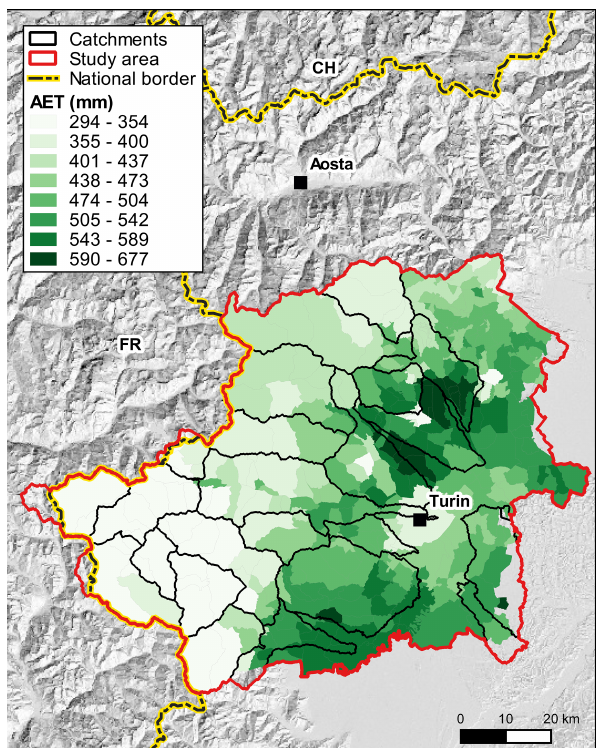
Figure 4. Spatial distribution of annual actual evapotranspiration.